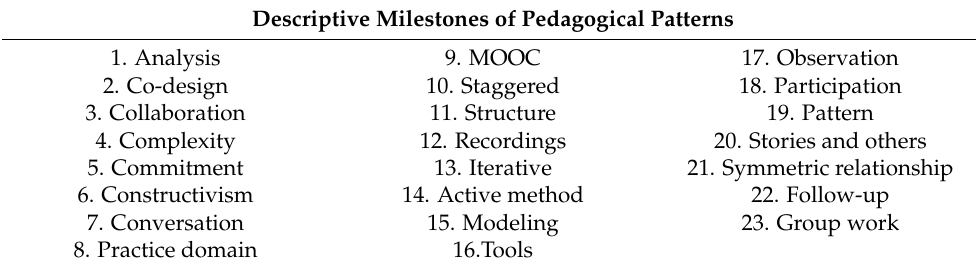
Table 6. Descriptive milestones of pedagogical patterns associated with tMOOC features and the general characteristics of patterns for university and non-university